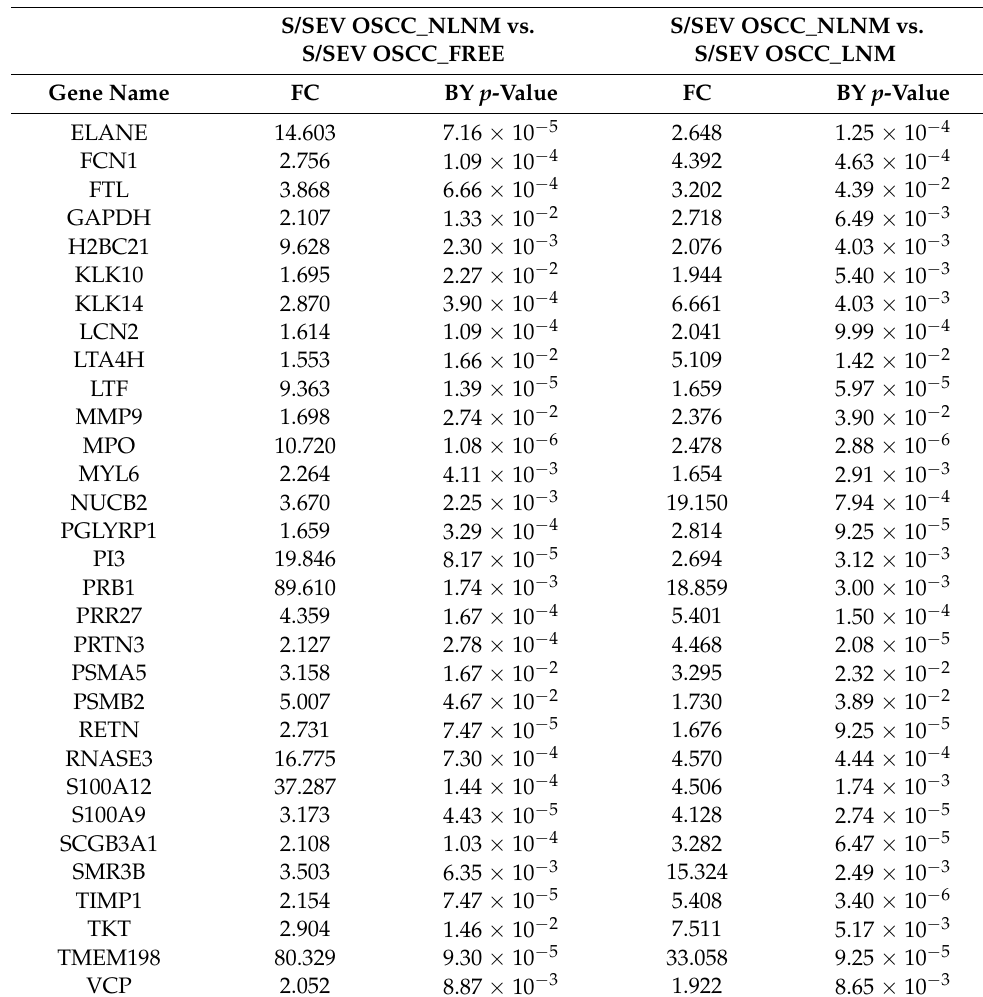
Table 7. Cont . PROTEINS UP-REPRESENTED in S/SEV OSCC_NLNM